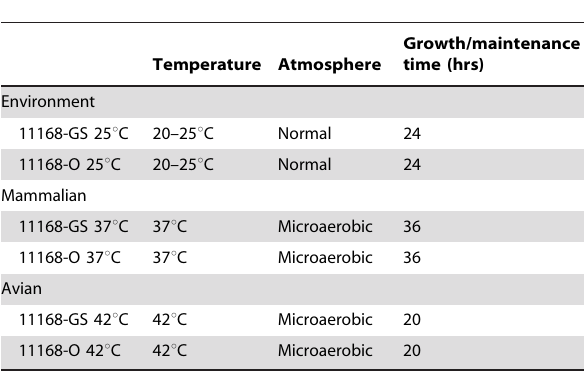
Table 1. C. jejuni 11168 genome sequenced (11168-GS) and 11168 original (11168-O) growth and/or maintenance conditions